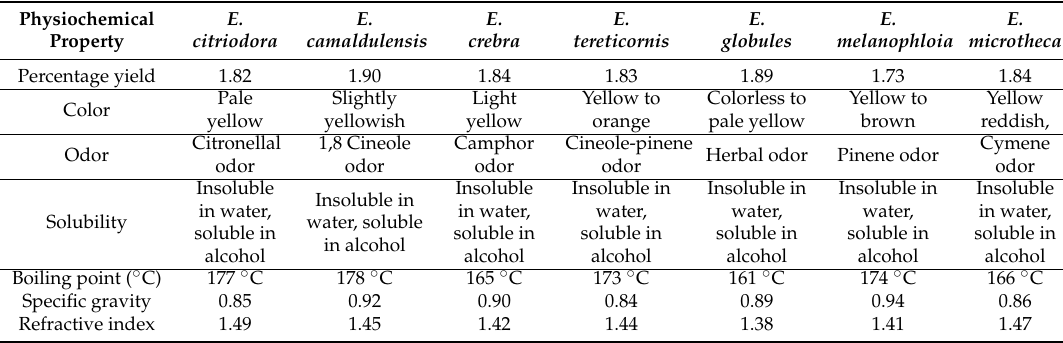
Table 1. Physiochemical properties of Eucalyptus essential